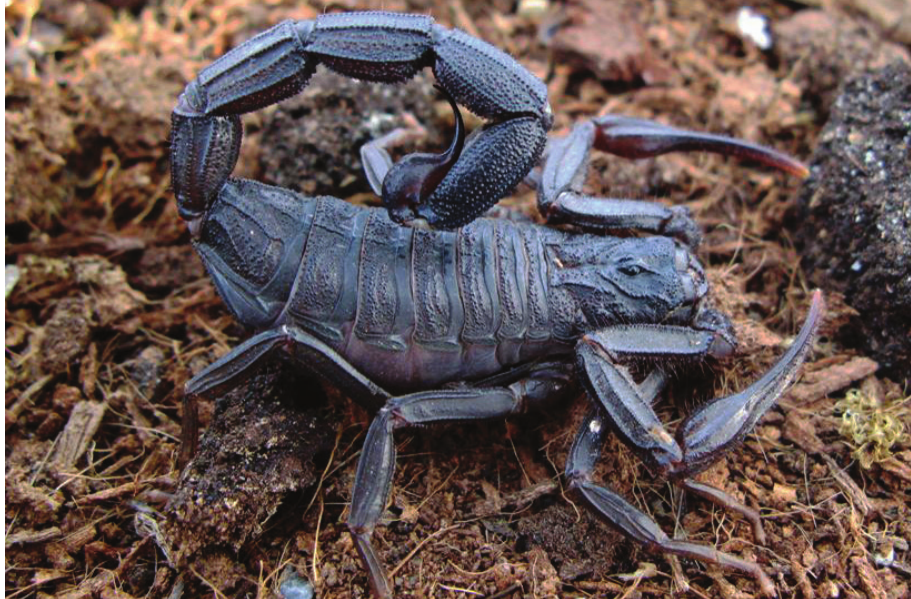
Figure 9. Jaguajir pintoi kourouensis , female from Kourou (photo G. Molisani). Genus Jaguajir Esposito, Yamaguti, Souza, Pinto da Rocha & Prendini, 2017 Jaguajir pintoi kourouensis (Lourenço, 2008) Fig. 9 References. Lourenço 1986, Lourenço and Pinto-da-Rocha 1997, Fet et al. 2000, Lourenço 2008, Esposito et al. 2017. Material. Region of Kourou, forest patches of Degrad path, one male (holotype), MNHN-RS-8631, mission M. Boulard & P. Pompanon coll., VIII/1975. Diagnosis. Large scorpion in relation to the species of the genus, with 89.7 mm in total length for the male holotype. Very dark coloration, uniformly black- ish. Carapace and mesosoma blackish. Venter dark reddish to blackish. Metasomal segments I to V blackish. Vesicle dark reddish to blackish. Chelicerae dark reddish with a blackish thread; fingers dark. Pedipalps blackish; fingers reddish. Legs dark reddish, intensely spotted with blackish. Carapace strongly granular; anterior mar- gin with a median concavity; anterior median and posterior median carinae strong; all furrows moderately deep. Tergites strongly granular; median carina strong in all tergites; tergite VII pentacarinate. Sternum triangular. Pectinal tooth count 24–25 in male. Sternites smooth with elongate spiracles; VII with four carinae and some lateral granulations. Metasomal segments I and II with ten carinae; III and IV with eight carinae; V with five carinae; inframedian carinae complete on II. Telson